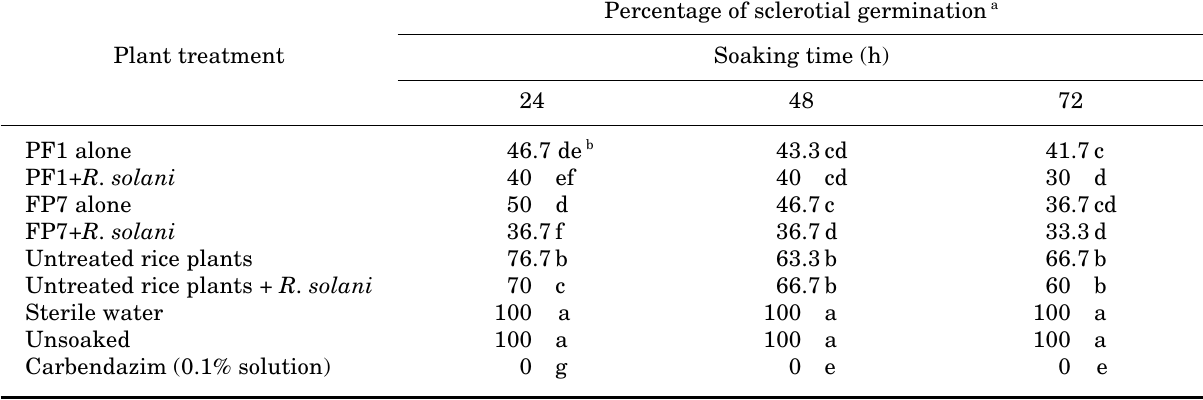
Table 3. Antifungal activity of plant sap extracted from rice plants treated with Pseudomonas fluorescens strains PF1 and FP7. Germination of Rhizoctonia solani sclerotia was recorded after soaking in the sap for 24, 48 or 72